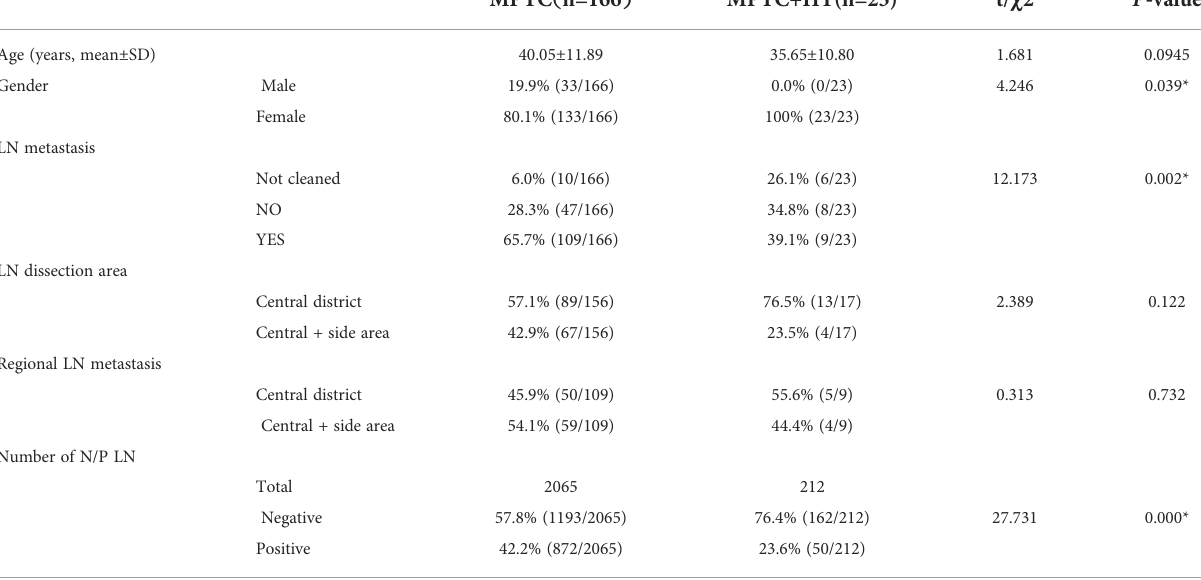
TABLE 6 Patient Characteristics of MPTC and MPTC with HT.